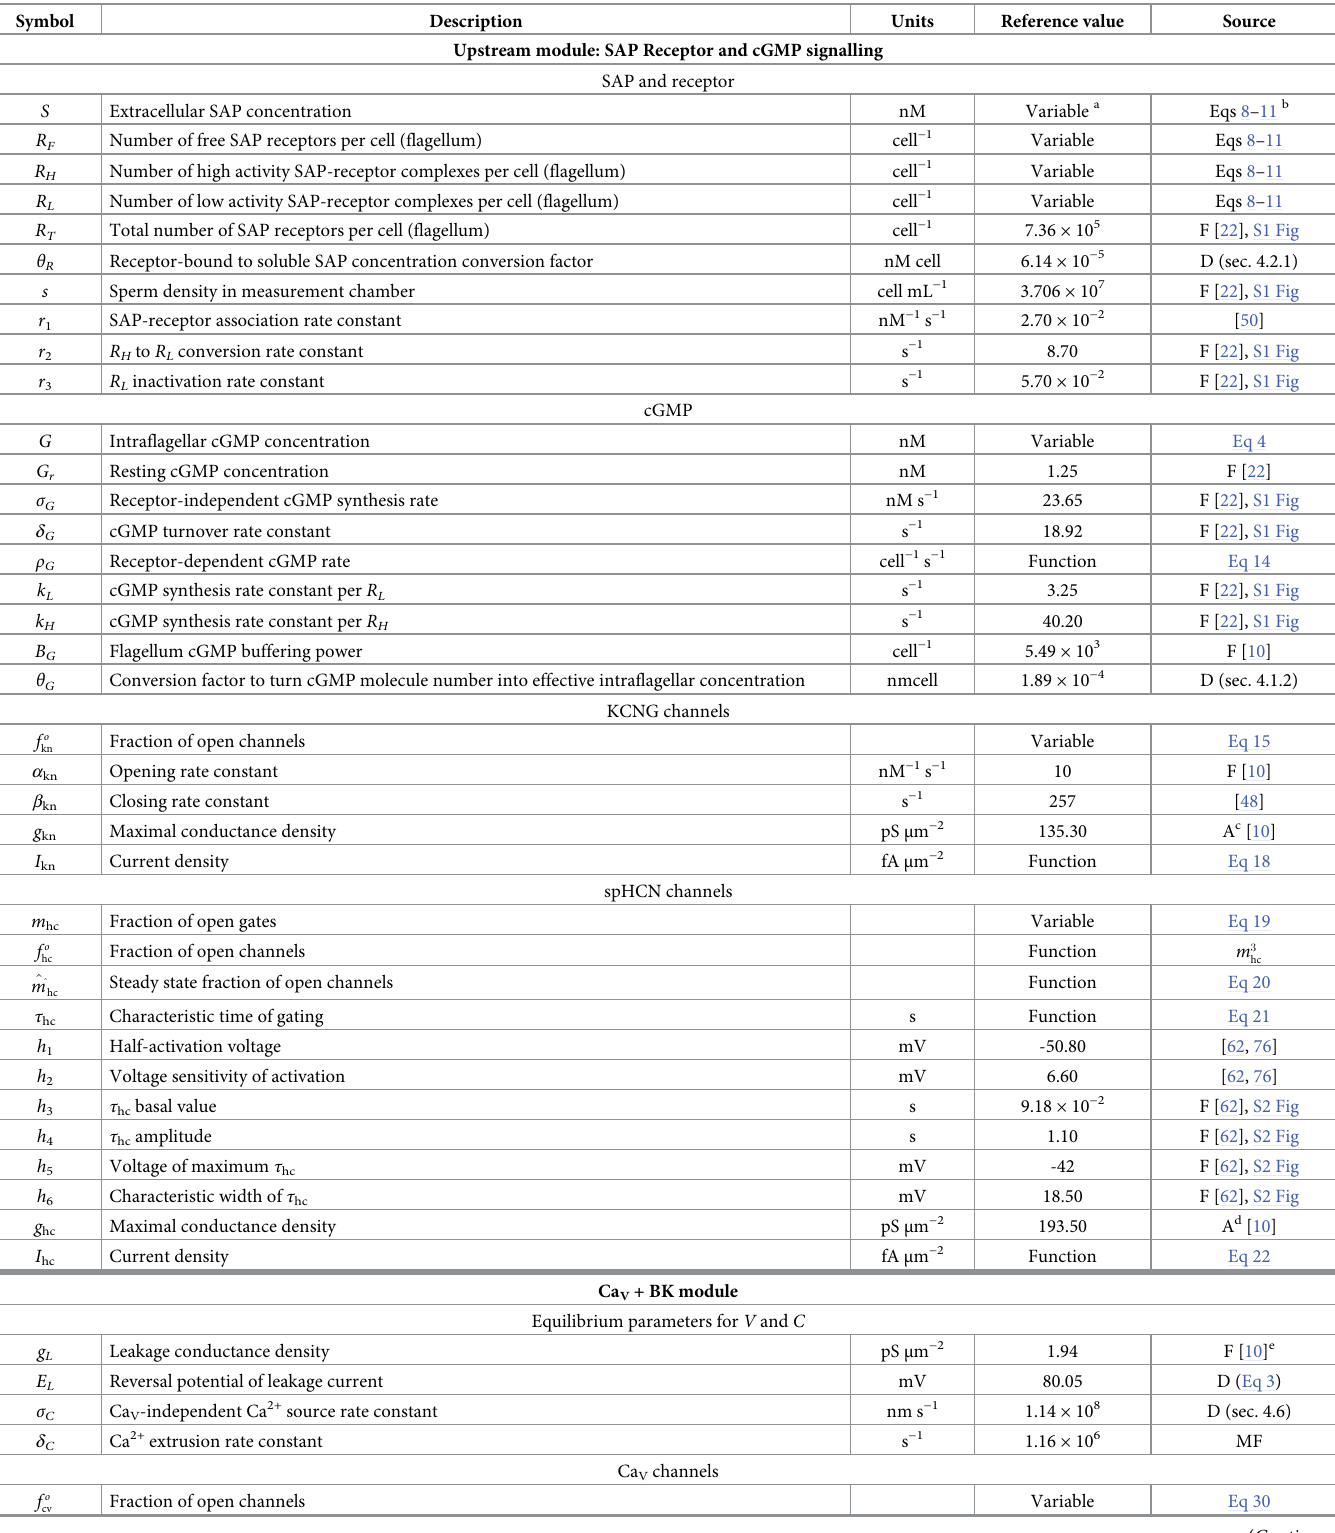
Table 2. Variables, intermediate functions, and reference parameters